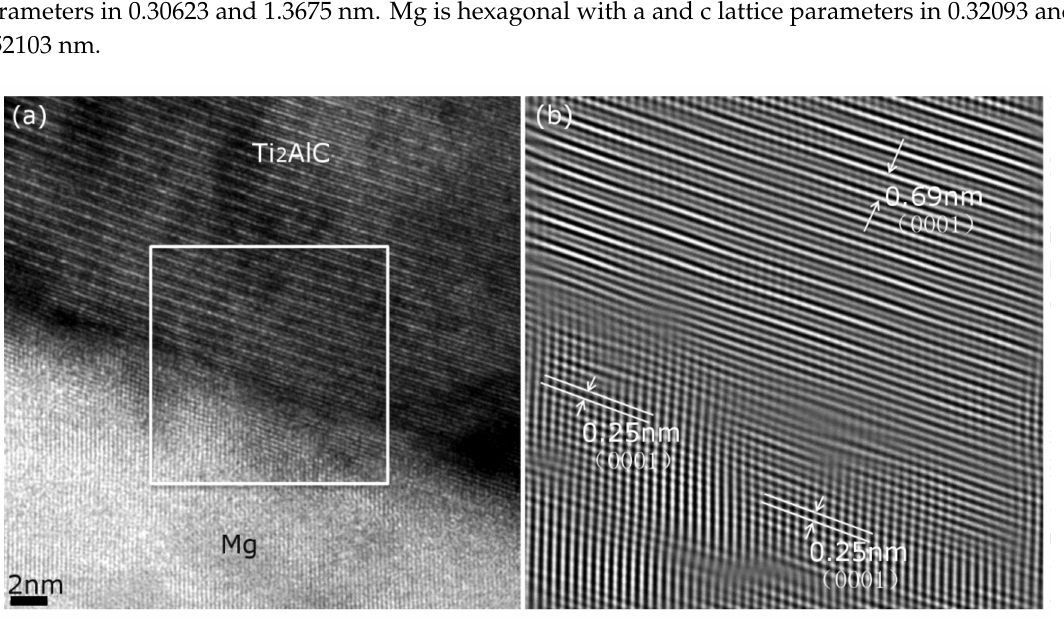
Figure 4. ( a ) High-resolution TEM (HRTEM) micrographs of AE44-Ti 2 AlC interface, ( b ) Fourier transformation of the marked rectangular zone in ( a